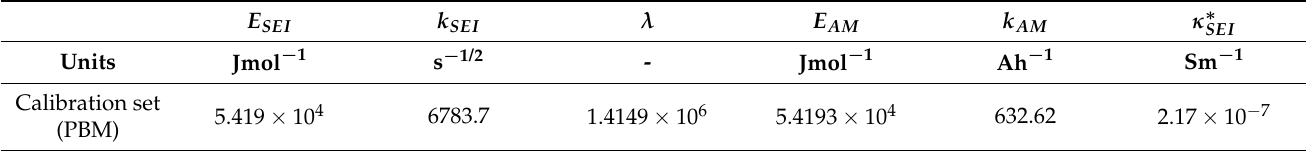
Table 2. Physics-based semi-empirical model: calibrated capacity and power fade model parameters.